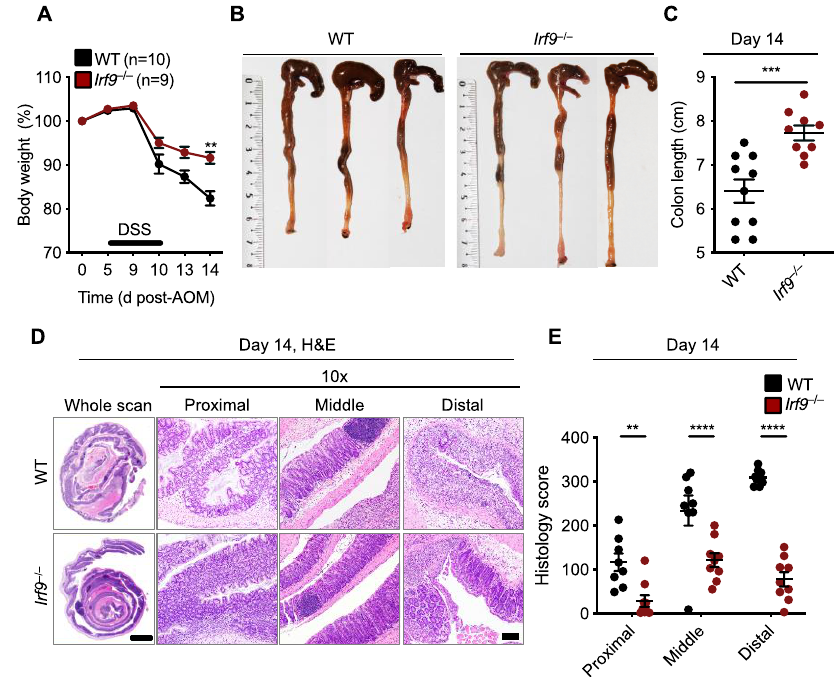
Figure 2. IRF9-deficient mice are resistant to DSS-induced colonic inflammation. ( A ) Body weight change of wild type (WT) (n = 10) and Irf9 –/– (n = 9) littermate mice. ( B , C ) Representative images of colon ( B ) and length of colon ( C ) in WT (n = 10) and Irf9 –/– (n = 9) mice 14 days after azoxymethane (AOM) injection. ( D ) Representative hematoxylin and eosin (H&E) staining of colon; scale bar, 2 mm for whole scan and 500 μm for proximal, distal, and middle colon. ( E ) Histological scores 14 days after AOM injection. Each symbol represents an individual mouse ( C , E ). ** p < 0.01; *** p < 0.001; **** p < 0.0001. One-way ANOVA ( A ); two-tailed t-test ( C ); and two-way ANOVA ( E ) were used. ns, not statistically significant. Data are from one experiment representative of three independent experiments ( A – E ).